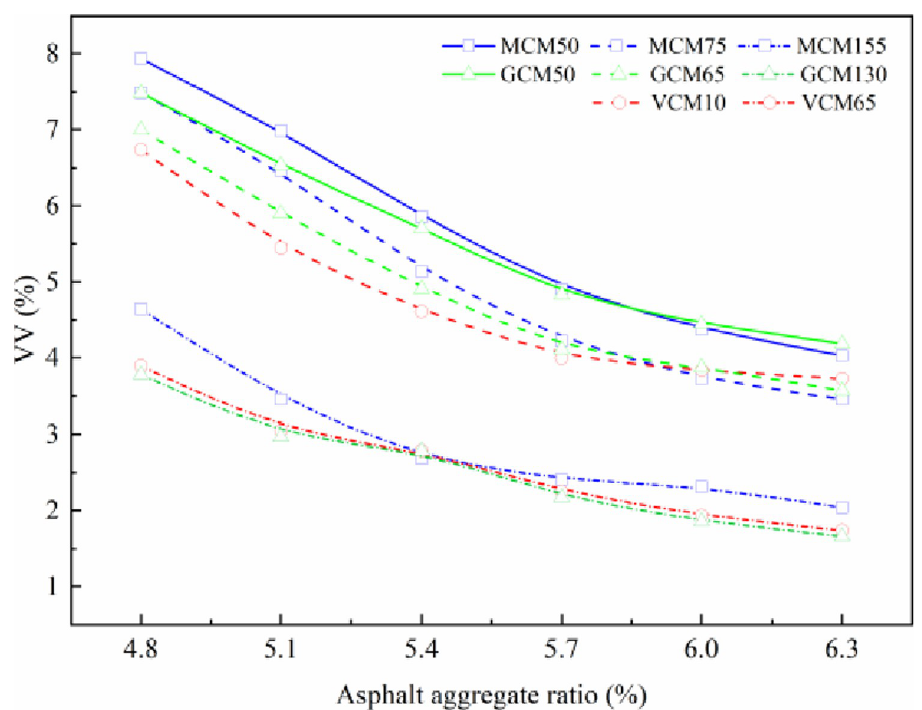
Fig 4. The relationship curve between VV and asphalt aggregate